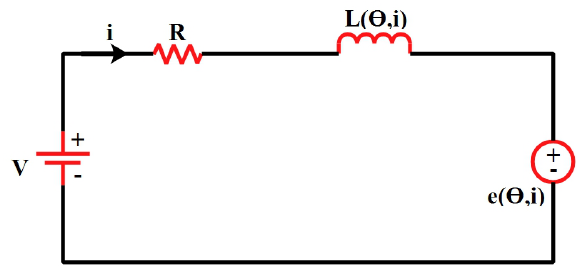
Fig. 1. Equivalent circuit of single-phase